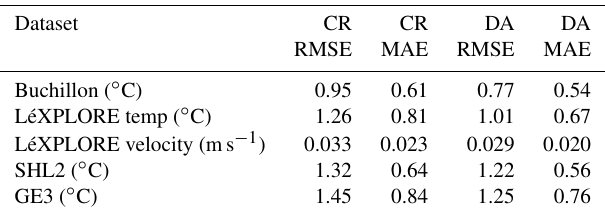
Figure 5. Marginal posterior (orange) and prior (blue) distributions of model parameters. The red dashed line indicates the maximum a posteriori parameter (MAP). Table 3. Performance of the DA run across the different in situ datasets in comparison to the CR. Note: CR is the control run, DA is the data-assimilated run, RMSE is the root mean square error, and MAE is the mean average